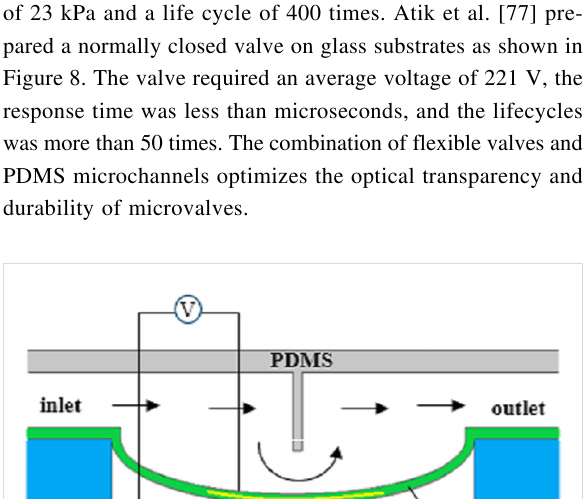
Figure 8: Schematic diagram of a flexible microvalve structure. Figure 8 was redrawn from [77].